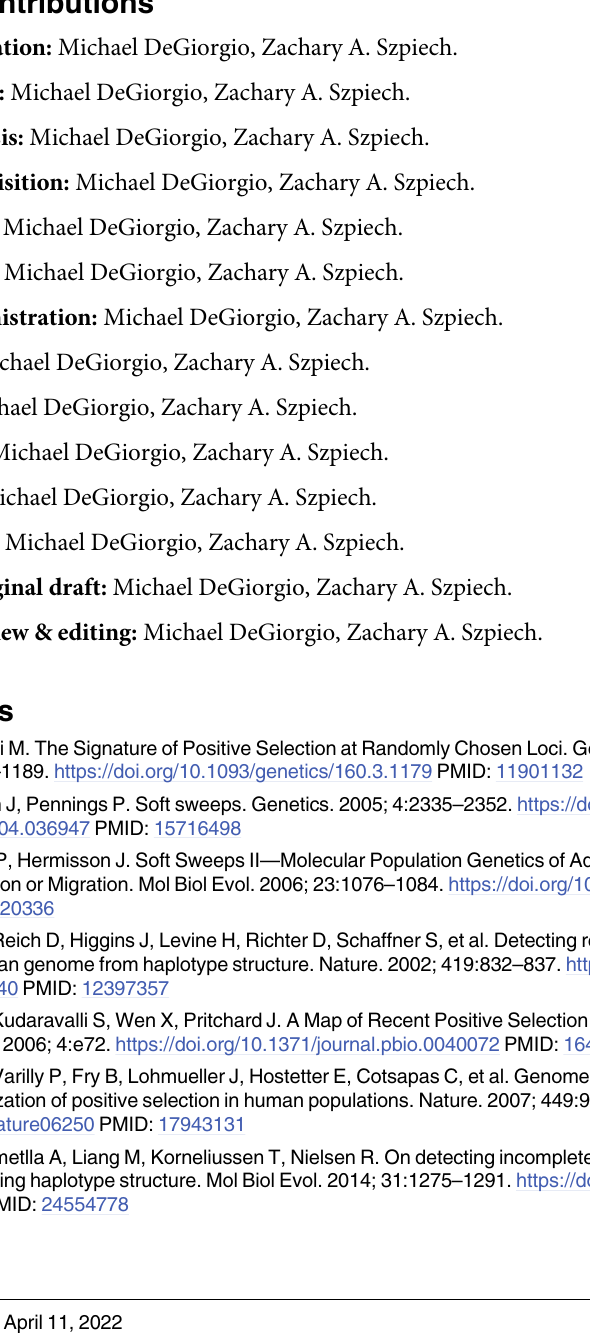
S8 Table. Regions of extreme Λ values in the New York City rat population that do not contain annotated genes in genome build RN5. ^ m is the inferred number of sweeping haplo- types, and log ð ^ A Þ is the estimated sweep 10